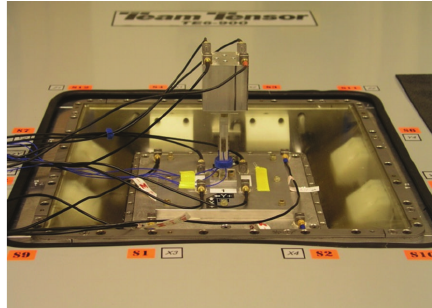
Figure 8: Simple structure under multiaxial loads